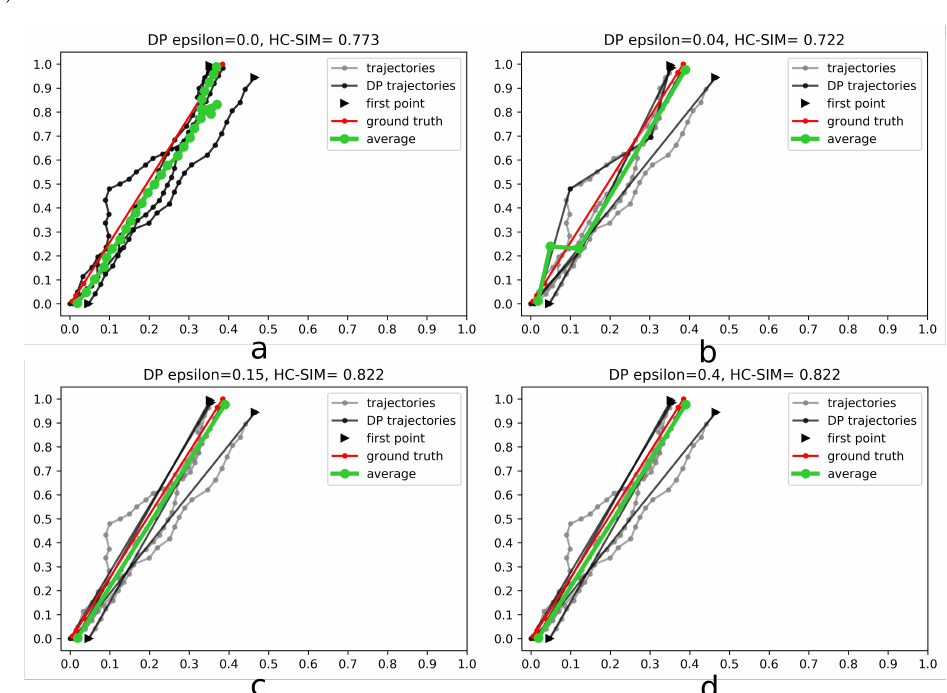
Figure A6. Algorithm applied to sample 10 with varying (cid:101) . ( a ) (cid:101) = 0.0, ( b ) (cid:101) = 0.04, ( c ) (cid:101) = 0.15, ( d ) (cid:101) =